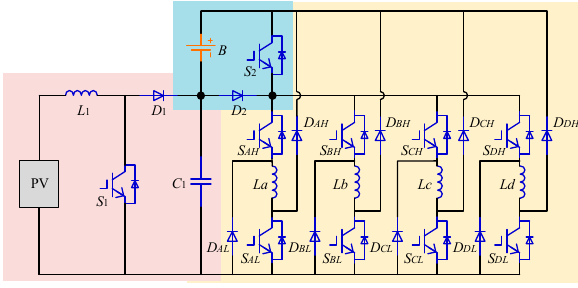
Figure 5. Proposed converter.